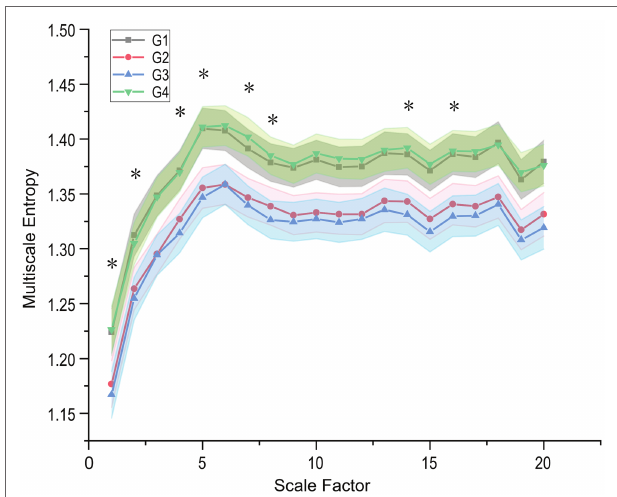
FIGURE 4 | Refined Composite Multi-Scale Entropy (RCMSE) curves (mean ± SE) for participants in the plateau simulation experiment. G1–G4 represents the four steady states in the experiment, respectively, and star- labelled complex indices represent significant differences in G2 and G3 (value of p < 0.05). The differences in complexity index (CI) of RCMSE with longitudinal changes over time are mainly concentrated in the low-frequency band (smaller